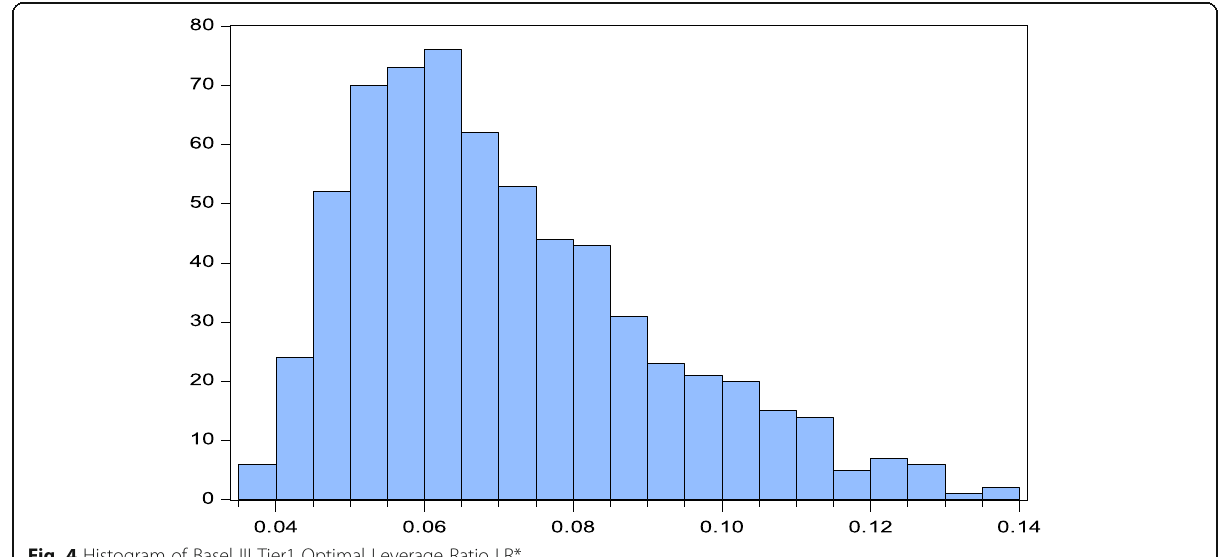
Fig. 4 Histogram of Basel III Tier1 Optimal Leverage Ratio